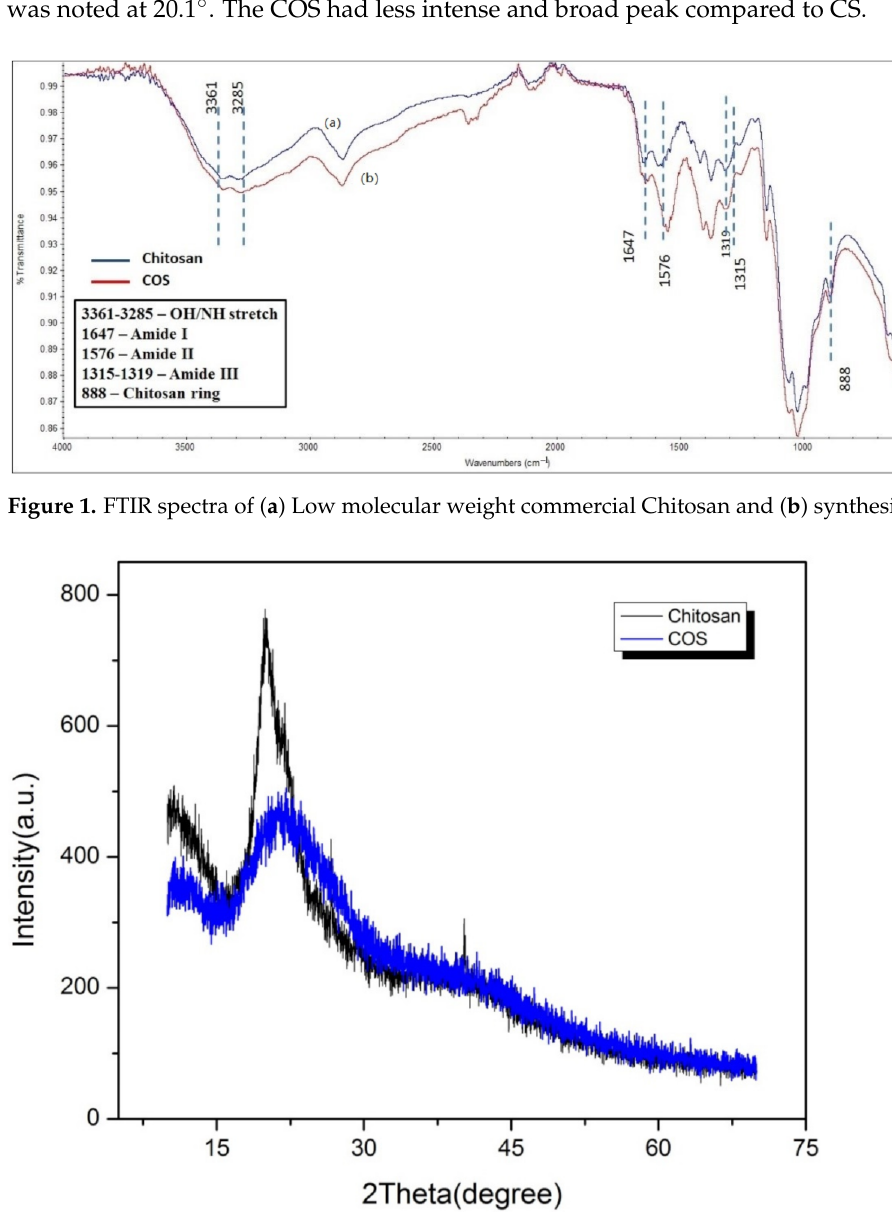
Figure 2. X-ray diffraction pattern of low molecular weight commercial chitosan and synthe- sized